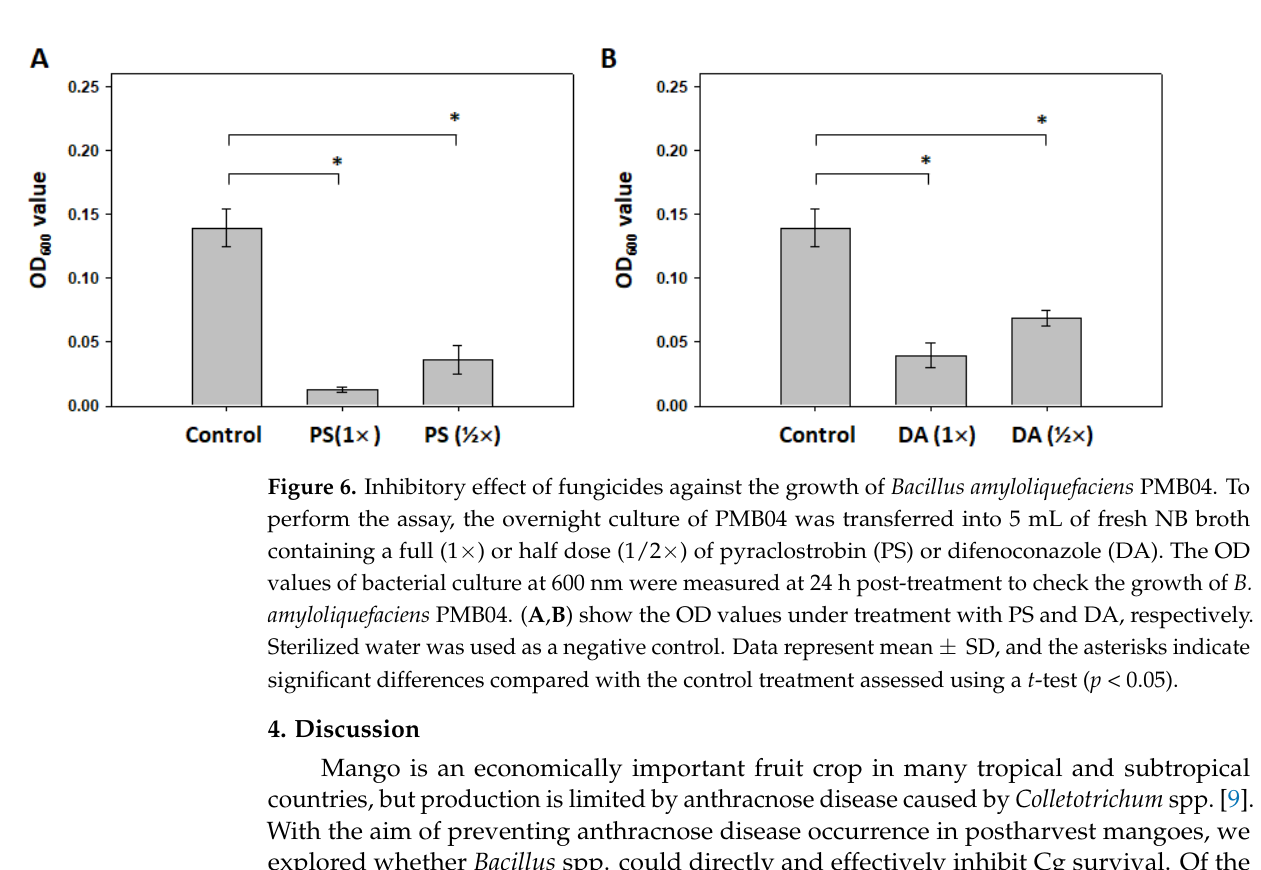
9 of 12 Figure 5. Control of combined Bacillus amyloliquefaciens PMB04 fermentation broth and fungicides against anthracnose disease in mango fruit. ( A ) shows the disease severity at 7 days post-inoculation. The surfaces of sterilized fruit were soaked in the 200-fold dilution of B. amylo- liquefaciens PMB04 fermentation broth (PMB04FB) containing a full (1×) or half dose (1/2×) of pyra- clostrobin (PS) or difenoconazole (DA) for 1 min as the treatment. The symbols “+” and “ − ” indicate the inclusion and exclusion, respectively, of the treatments. A negative control was performed with sterilized water alone. A spore suspension of Colletotrichum gloeosporioides was then spotted on the surface of the fruit for inoculation. Data represent mean ± SD. Different letters above the columns indicate significant differences based on Tukey’s HSD test ( F = 36.9; p < 0.05). ( B ) displays the symptom appearances of the different treatments on fruit. 3.6. Growth Inhibition of Bacillus Amyloliquefaciens PMB04 by Fungicides